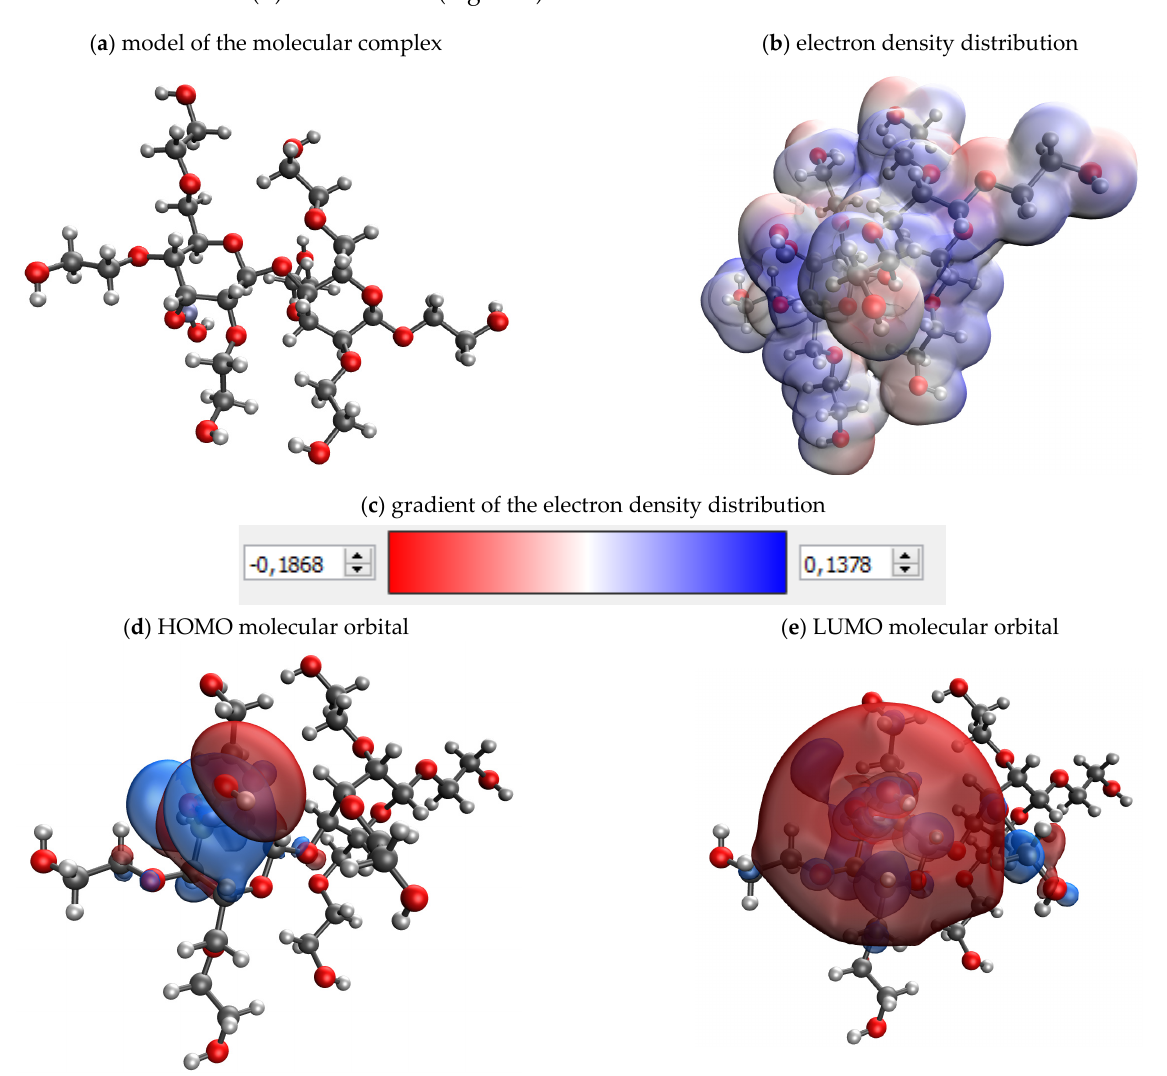
Figure 9. Results of quantum chemical modeling of the molecular system “ZnO-hydroxyethyl cellulose”.